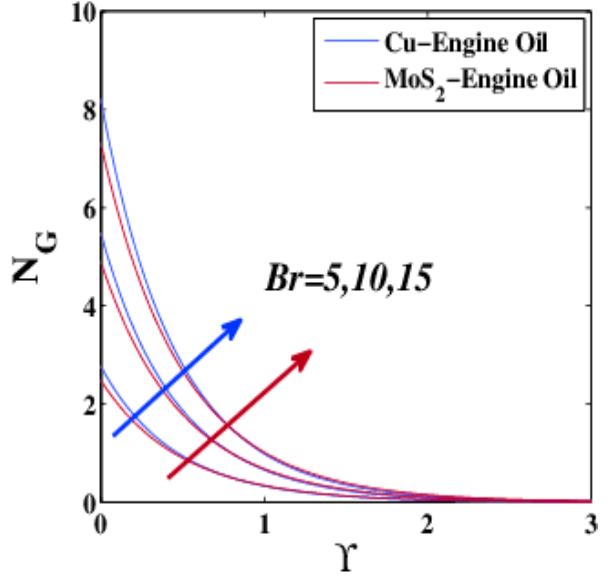
Figure 31. Entropy generation variation N G under the influence of Br Table 4. Calculations of the Nusselt number = 𝑁